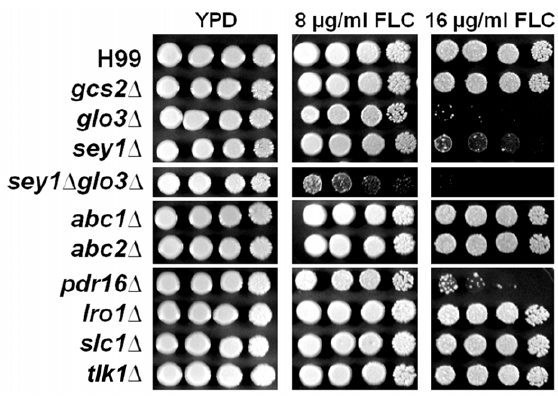
Figure 2. Spot assay for FLC tolerance. Cells of the indicated strains were spotted on YPD alone or YPD supplemented with either 8 m g/ml or 16 m g/ml FLC and incubated at 30 u C for 5 days. Increase in sensitivity to FLC was seen in strains containing disruptions of several genes on Chr4 including, GLO3 , SEY1 and PDR16 .